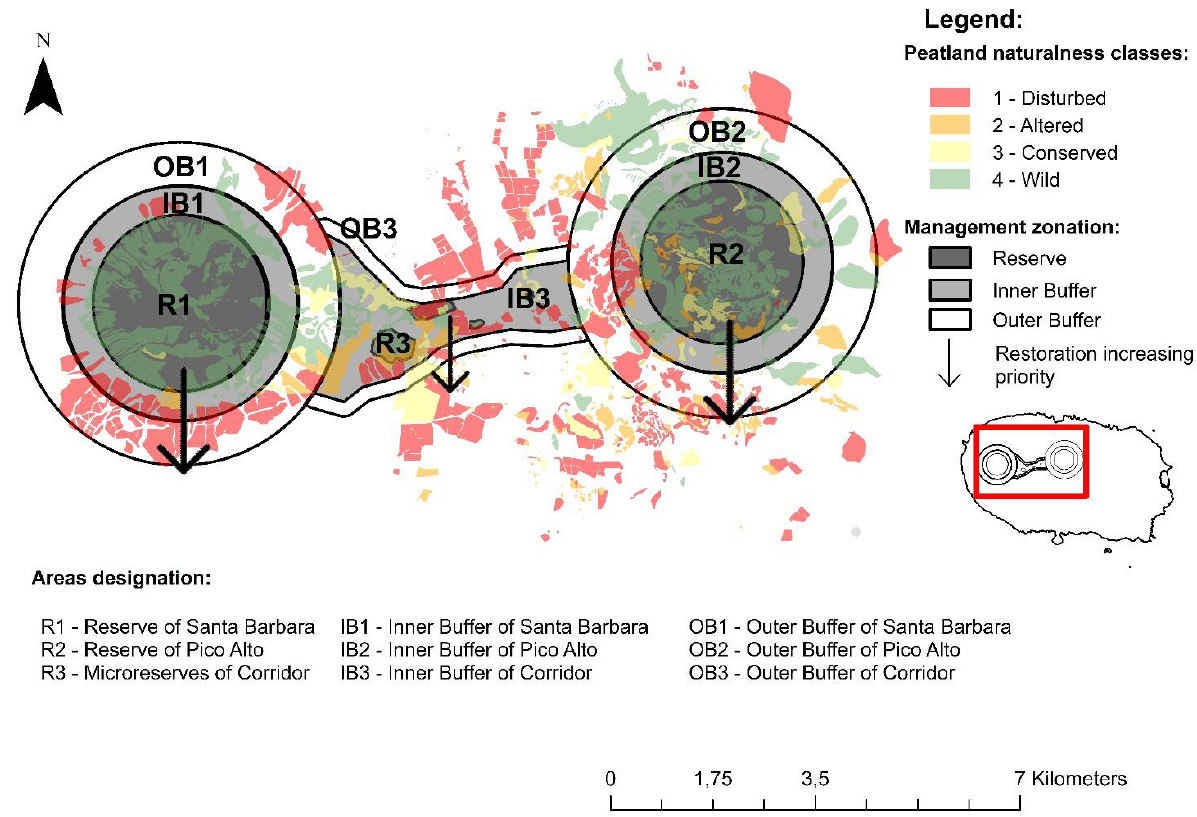
Figure 7. Definition of a theoretical management zonation model for Terceira peatlands, with the definition of three classes: reserve, inner buffer and outer buffer. This model is intended to define priority areas for restoration, expanding from the reserve into the outer buffer . Digital base map: Military Map 1:25000.